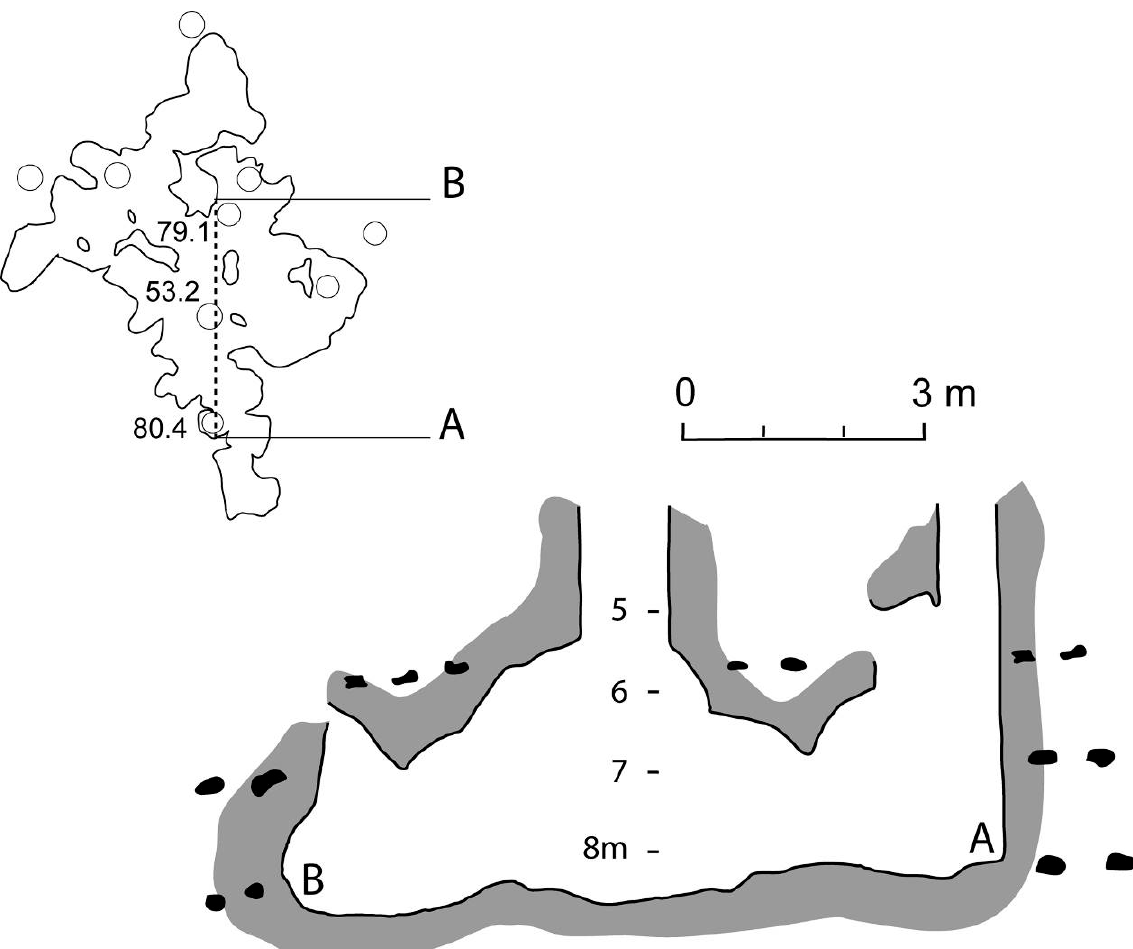
Figure 17. Petit-Spiennes. Cross section of 53.2 shaft in the sector excavated by the SRPH from 1953 to 2003. Graphics by M. Woodbury, SPW after Gosselin